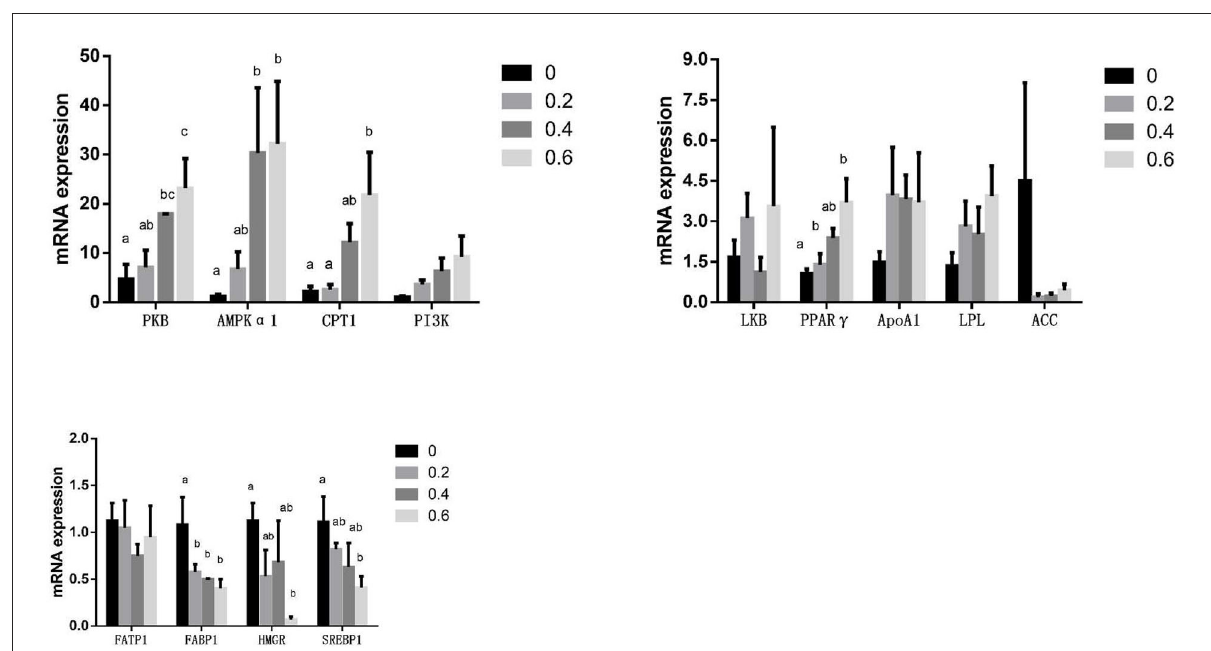
FIGURE2 Effects of quercetin on mRNA expression of genes related to the PI3K/PKB/AMPK signaling pathway in the breast muscle of AA broilers.